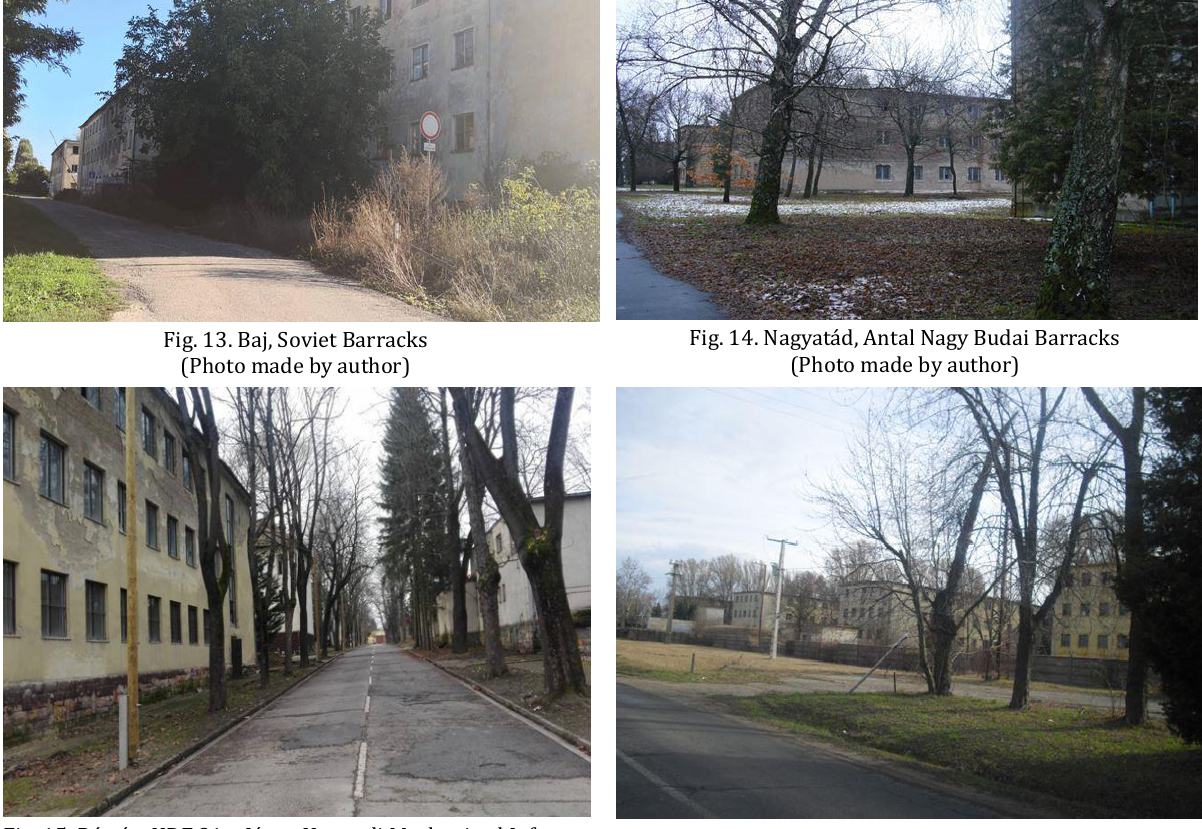
Fig. 15. Rétság, HDF 31st János Hunyadi Mechanized Infantry